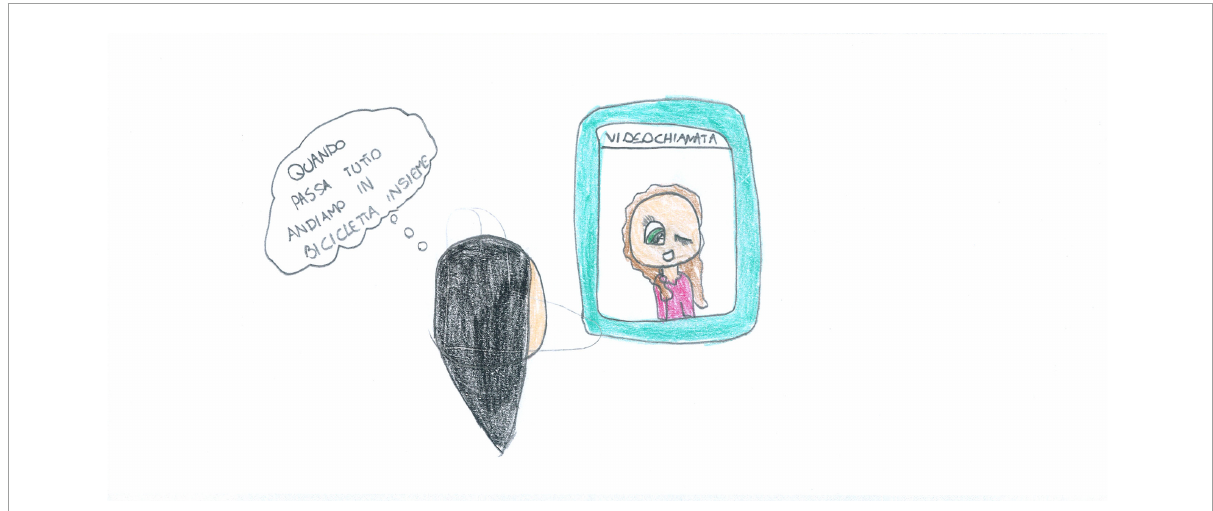
FIGURE13 An example of two girls actively using ICT for a chat. The girl is saying: “when this is over, we’ll ride together in our bicycle” (PS, Female, 10 years).